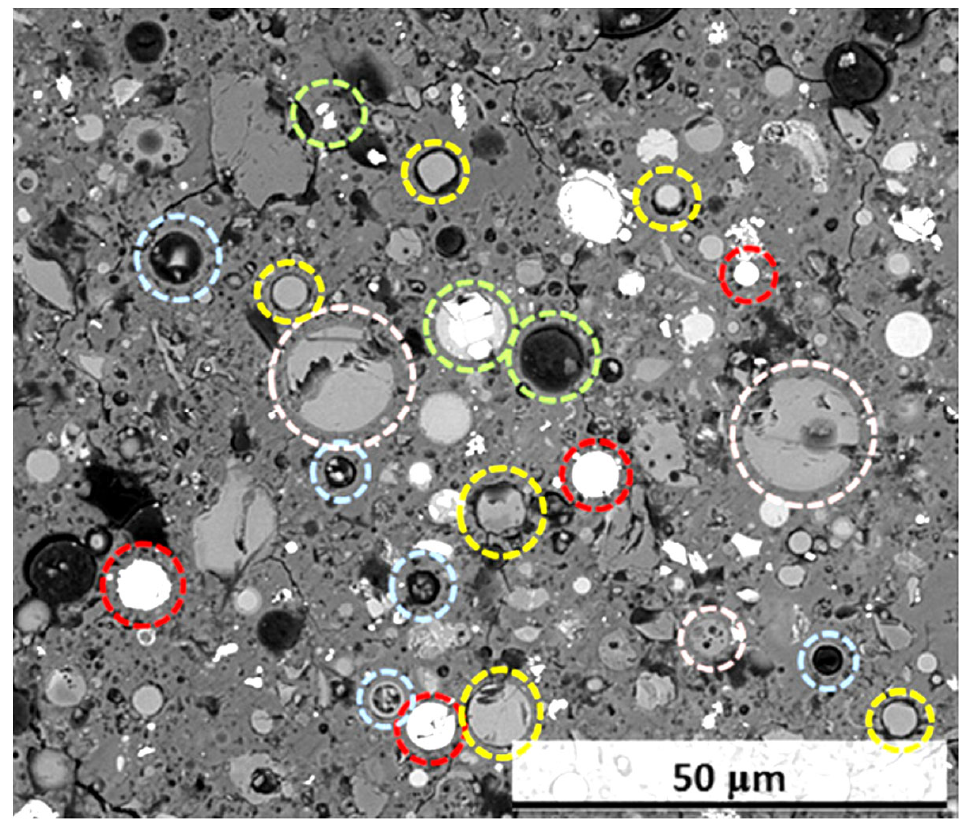
Figure 19. SEM image of a refined segment of an FA ‐ GP concrete with several FA particle types highlighted in various colors. Yellow particles are reactive glass particles surrounded by a reaction rim [222–224]; red particles are iron-rich; pink particles are relatively unreactive glass particles with no visible reaction rim; blue particles are hollow particles whose shell was not broken during the reaction process; green particles contain visible crystalline inclusions. Adapted from [225]. Table 4. Effect of different additives on FA ‐ GP concrete CS.